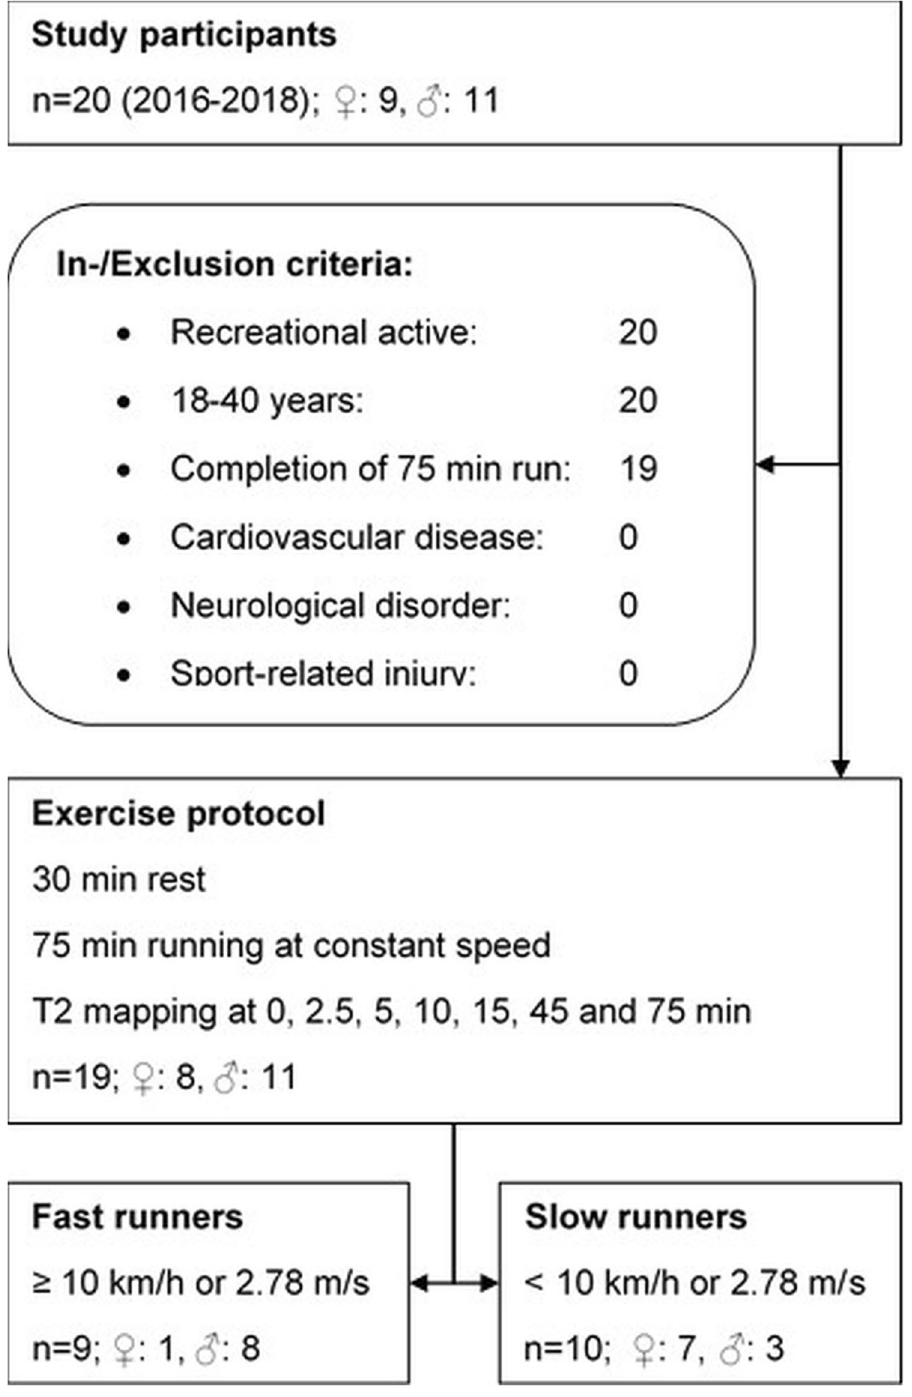
Figure 1. Flow diagram for study participants with exercise protocol and subgroup